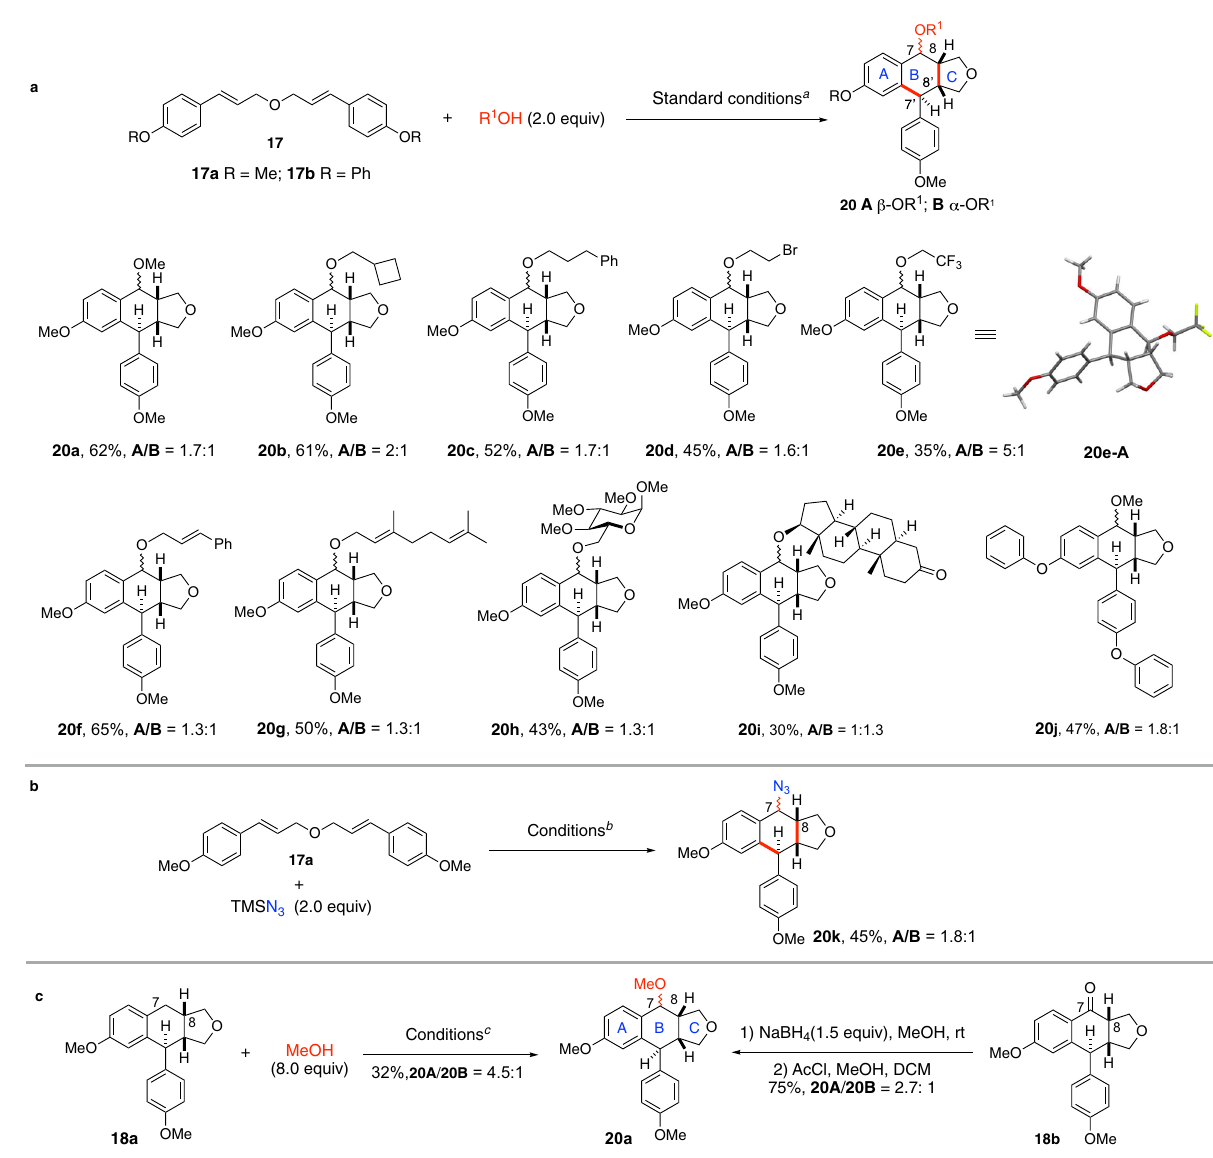
Fig. 3 Synthesis of C7-functionalized aryltetraline cyclic ethers. a Synthesis of C7-alkoxylated aryltetralin cyclic ethers: Standard conditions: 17 (0.1mmol), ROH (0.2mmol, 2.0 equiv), [Mes-Acr-Me] + BF 4 − ( 16 ) (5mol%), Cu(TFA) 2 (cid:129) x H 2 O (0.12mmol, 1.2 equiv), DCM (4.0mL, c 0.025M), 24W blue LED, 23°C, isolated yields. CF 3 CH 2 OH (4 equiv) was used in the case of 20e ; b Synthesis of C7-azido aryltetralin cyclic ether. TMSN 3 (0.2mmol, 2.0 equiv) was used as nucleophile instead of alcohol under otherwise standard conditions; c Conditions: 18a (0.1mmol), [Mes-Acr-Me] + BF 4 − ( 16 ) (5mol%), Cu(TFA) 2 (cid:129) x H 2 O (0.12mmol, 1.2 equiv), DCM (4.0mL, c 0.025M), 24W blue LED, N 2 , 23°C. Yields refer to isolated pure